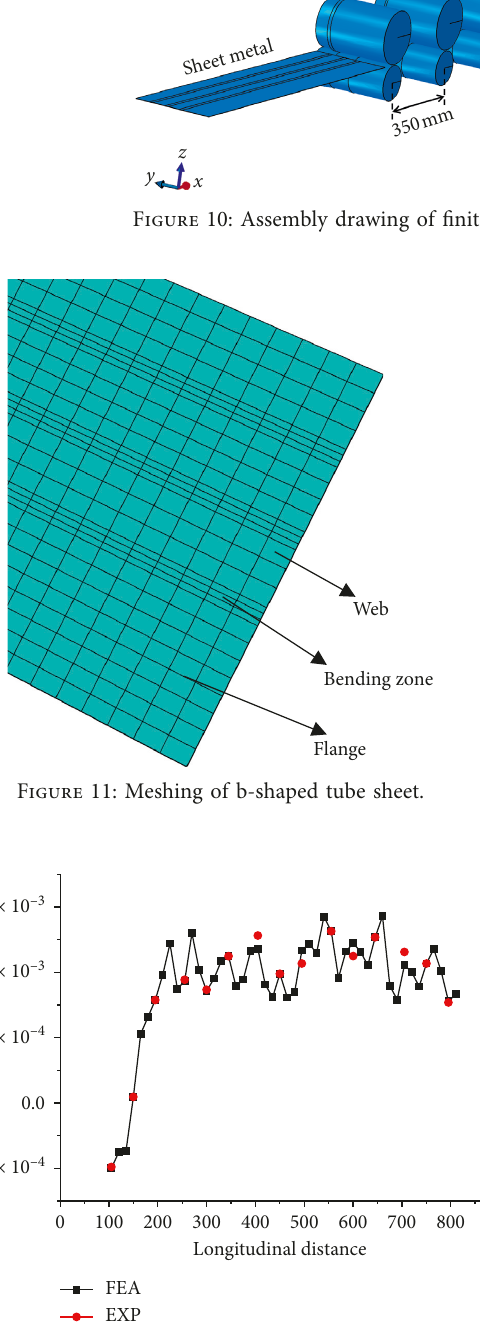
Figure 12: Experimental and simulation comparison of flange top